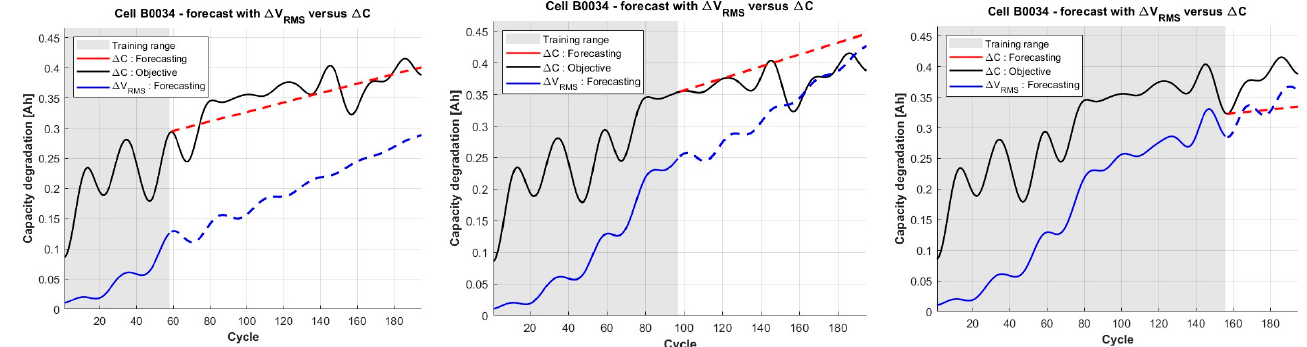
Figure 9. ARIMA predictions at different cycles for cell B0034 with a discharge current of 4 A (C-rate of 2). Behavior of the measured capacity fade ∆ C (black line, which corresponds to the objective time series), the prediction results with the proposed ∆ V RMS health indicator in the scale of ∆ C (blue line) and the prediction of ∆ C (red line).